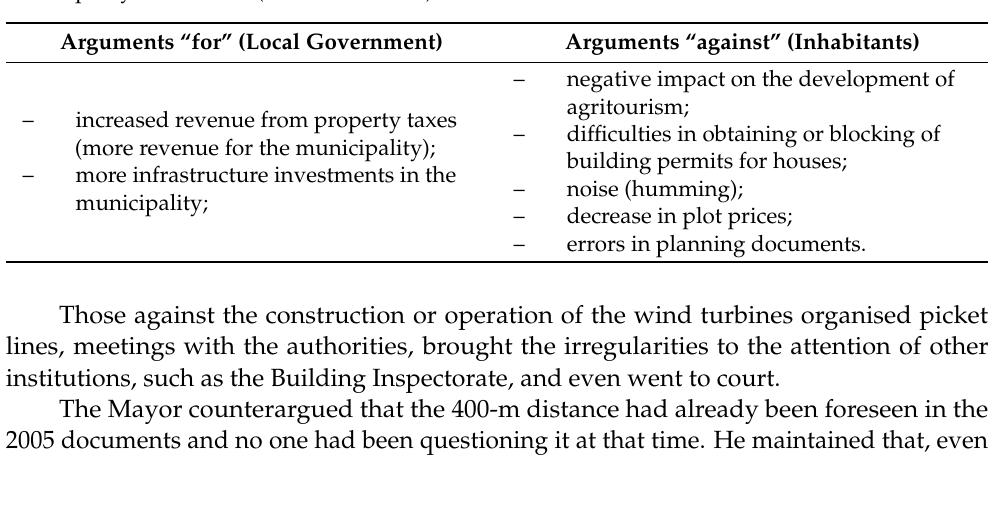
Table 4. Main arguments “for” and “against” the construction and operation of wind turbines in the municipality of Darłowo (own